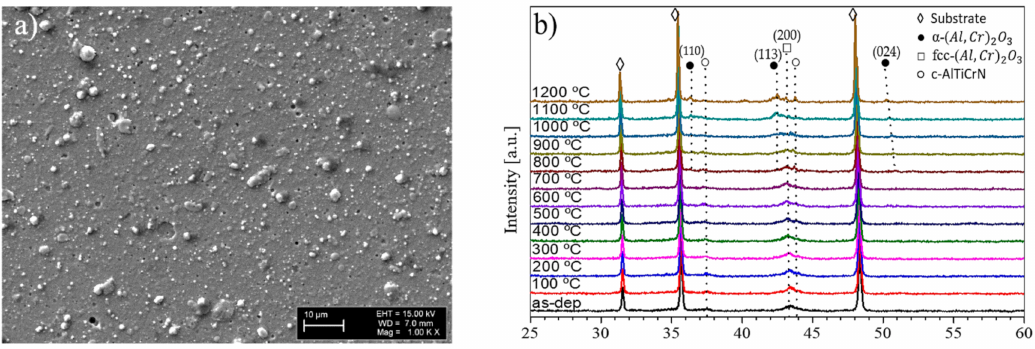
Figure 1. SEM image taken on pristine coating surface ( a ) and ( b ) HT-XRD